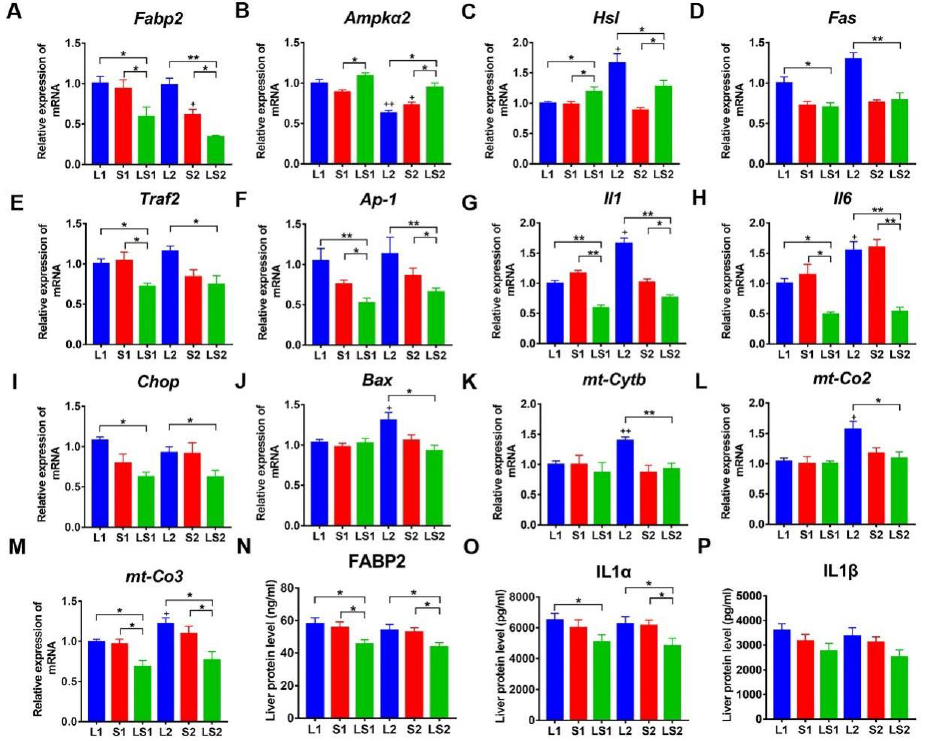
Figure 8. Verified differentially expressed genes of Fabp2 , Ampk α 2 , Hsl, Fas, Traf2 , Ap-1 , Il1 , Il6 , Chop , Bax , mt- Cytb , mt-Co2, and mt-Co3 ( A – M , respectively); protein levels of FABP2, IL-1 α , and IL-1 β ( N – P , respectively). “*” represents significant differences at p < 0.05; “**” denote s considerable differ- ences at p < 0.01; “+” shows significant variations at p < 0.05 relative to the same oil type with differ- ent energy level; “++” represents significant differences at p < 0.01 relative to the same oil type with different energy level.